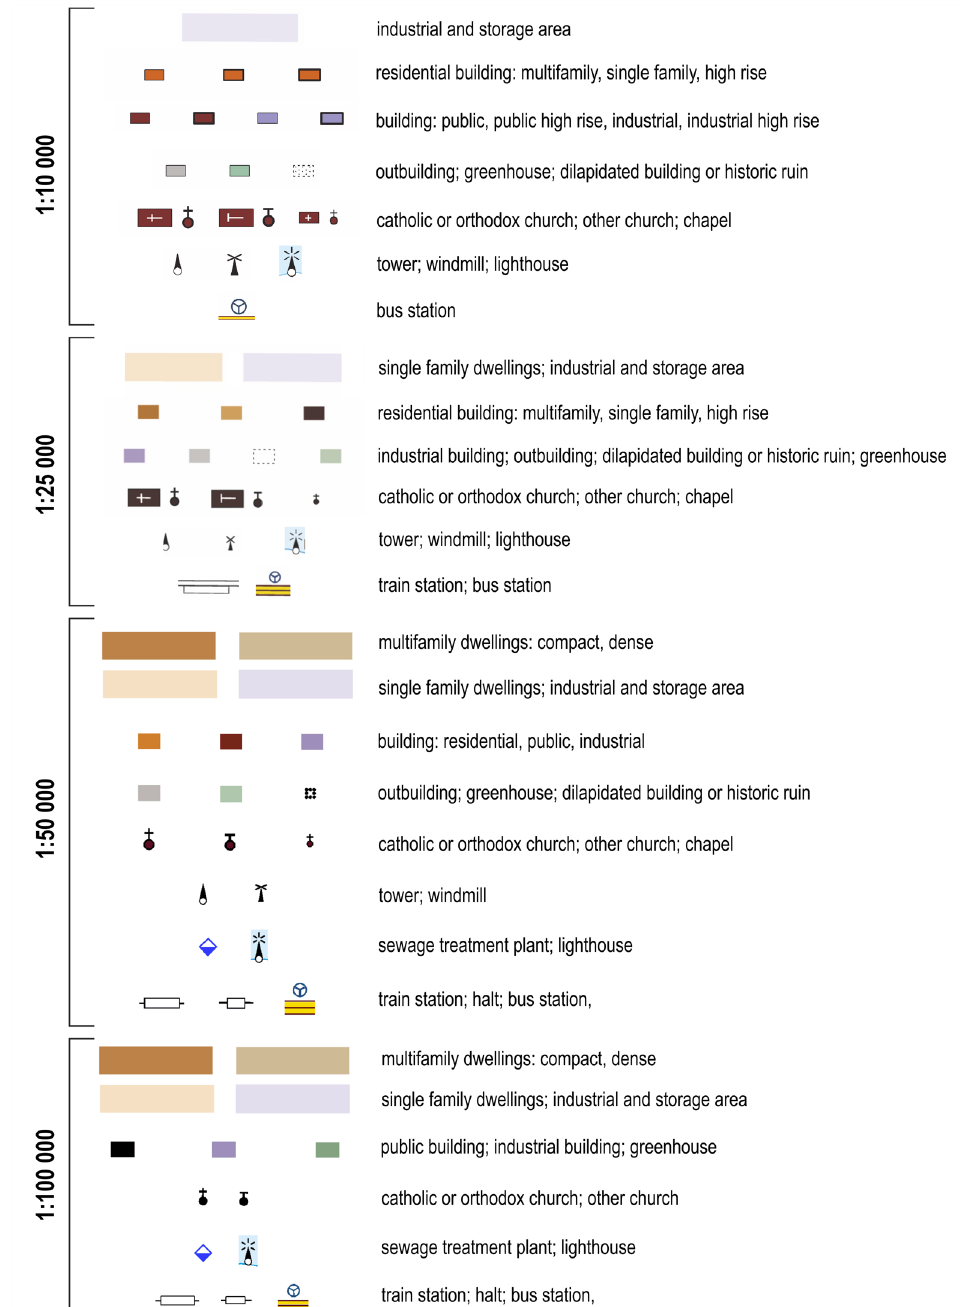
Fig. 3. Parts of legends of topographic maps developed on the basis of